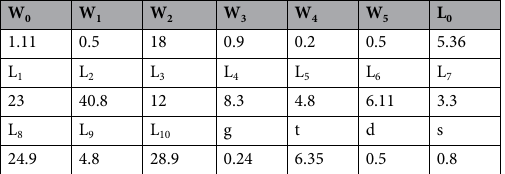
Table 2. Dimensions of dual-band power divider (unit: mm).